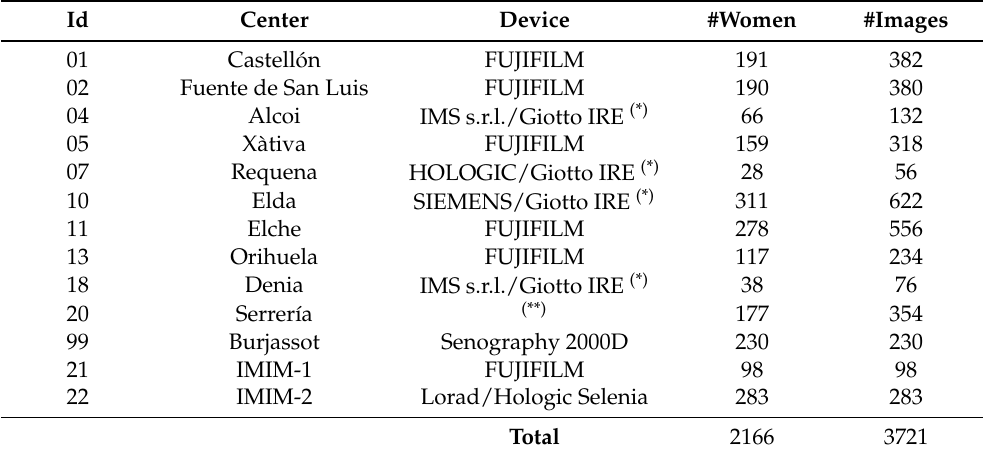
Table 1. Summary of the screening centers, their mammography devices and the number of women and mammograms per device.